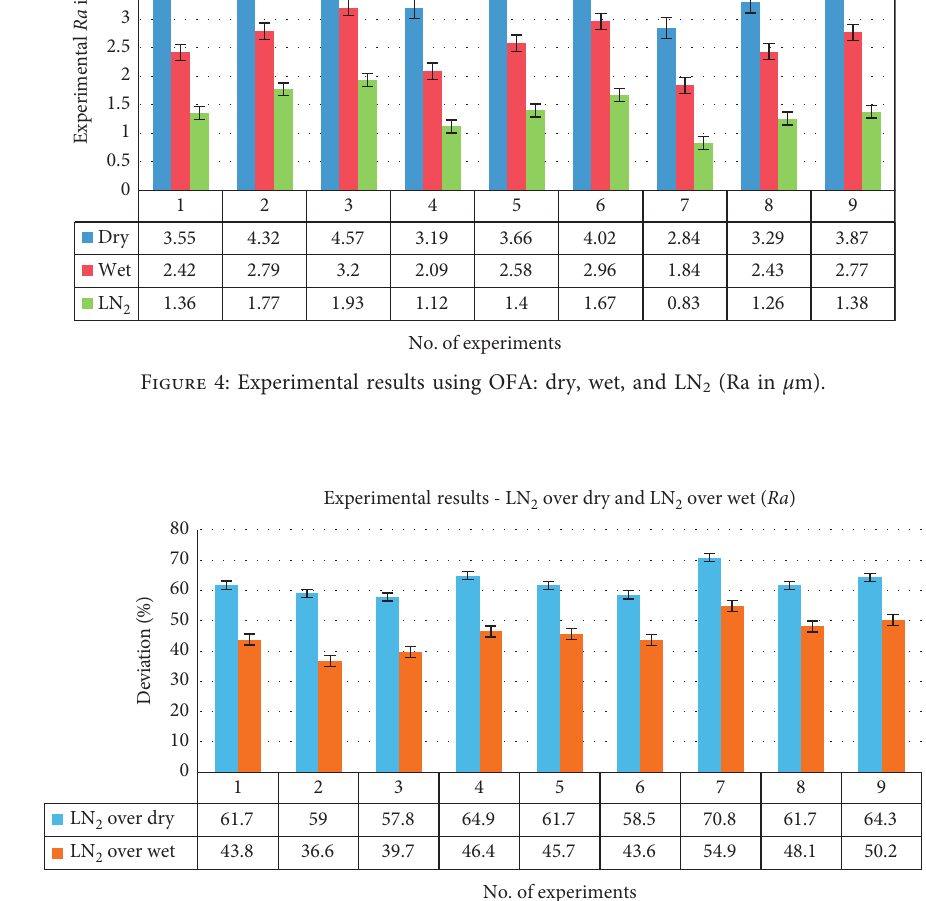
Figure 5: Percentage deviation in experimental results using OFA: LN